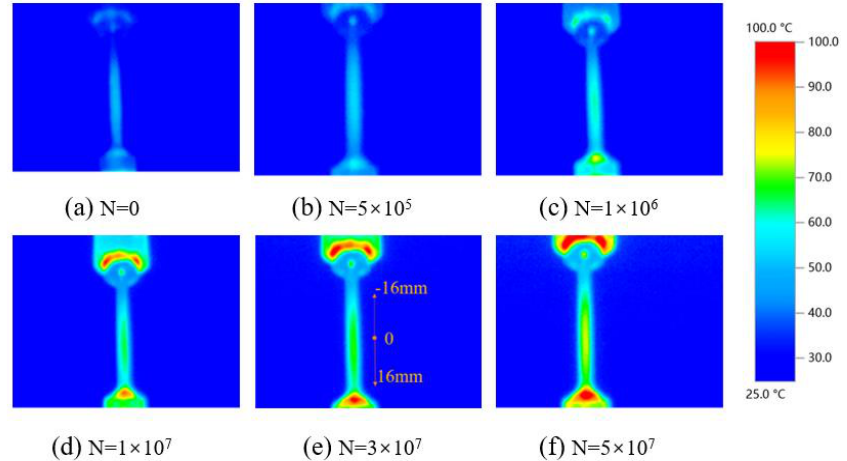
Figure 4. Full-surface view of thermography measurements of BM under different cycles at  a = σ a = 645 MPa: ( a ) N = 0, ( b ) N = 5 × 10 5 , ( c ) N = 1 × 10 6 , ( d ) N = 1 × 10 7 , ( e ) N = 3 × 10 7 , 645 MPa: ( a ) N=0, ( b ) N=5 × 10 5 , ( c ) N= 1 × 10 6 , ( d ) N=1 × 10 7 , ( e ) N=3 × 10 7 , ( f ) N=5 × 10 7 . ( f ) N = 5 × 10 7